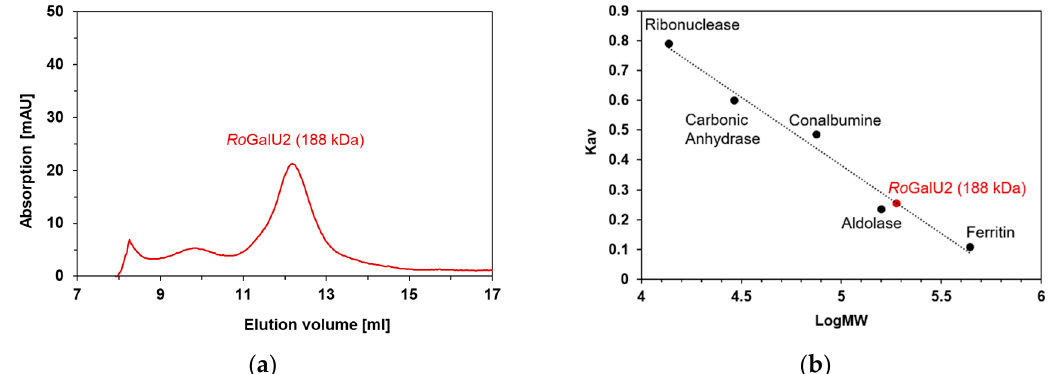
Figure 4. Size exclusion chromatography of Ro GalU2 ( a ) and the corresponding calibration measurements ( b ). The calibration curve was prepared with the following proteins of known molecular weight (given in brackets): Ribonuclease (13.7 kDa), Carbonic Anhydrase (29 kDa), Conalbumin (75 kDa), Aldolase (158 kDa) and Ferritin (440 kDa). All elutions were performed in a buffer containing 50 mM Hepes, pH 7.0 and 1 mM magnesium chloride. See methods Section 4.5. The protein concentration was either 0.2 or 2.0 mg ml − 1 whereas the latter is presented herein.